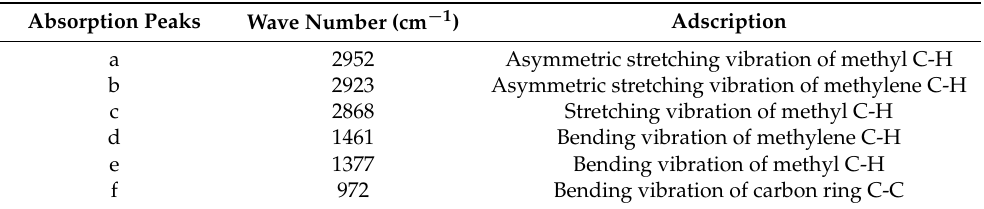
Table 3. Attribution of main IR absorption peaks of oil.